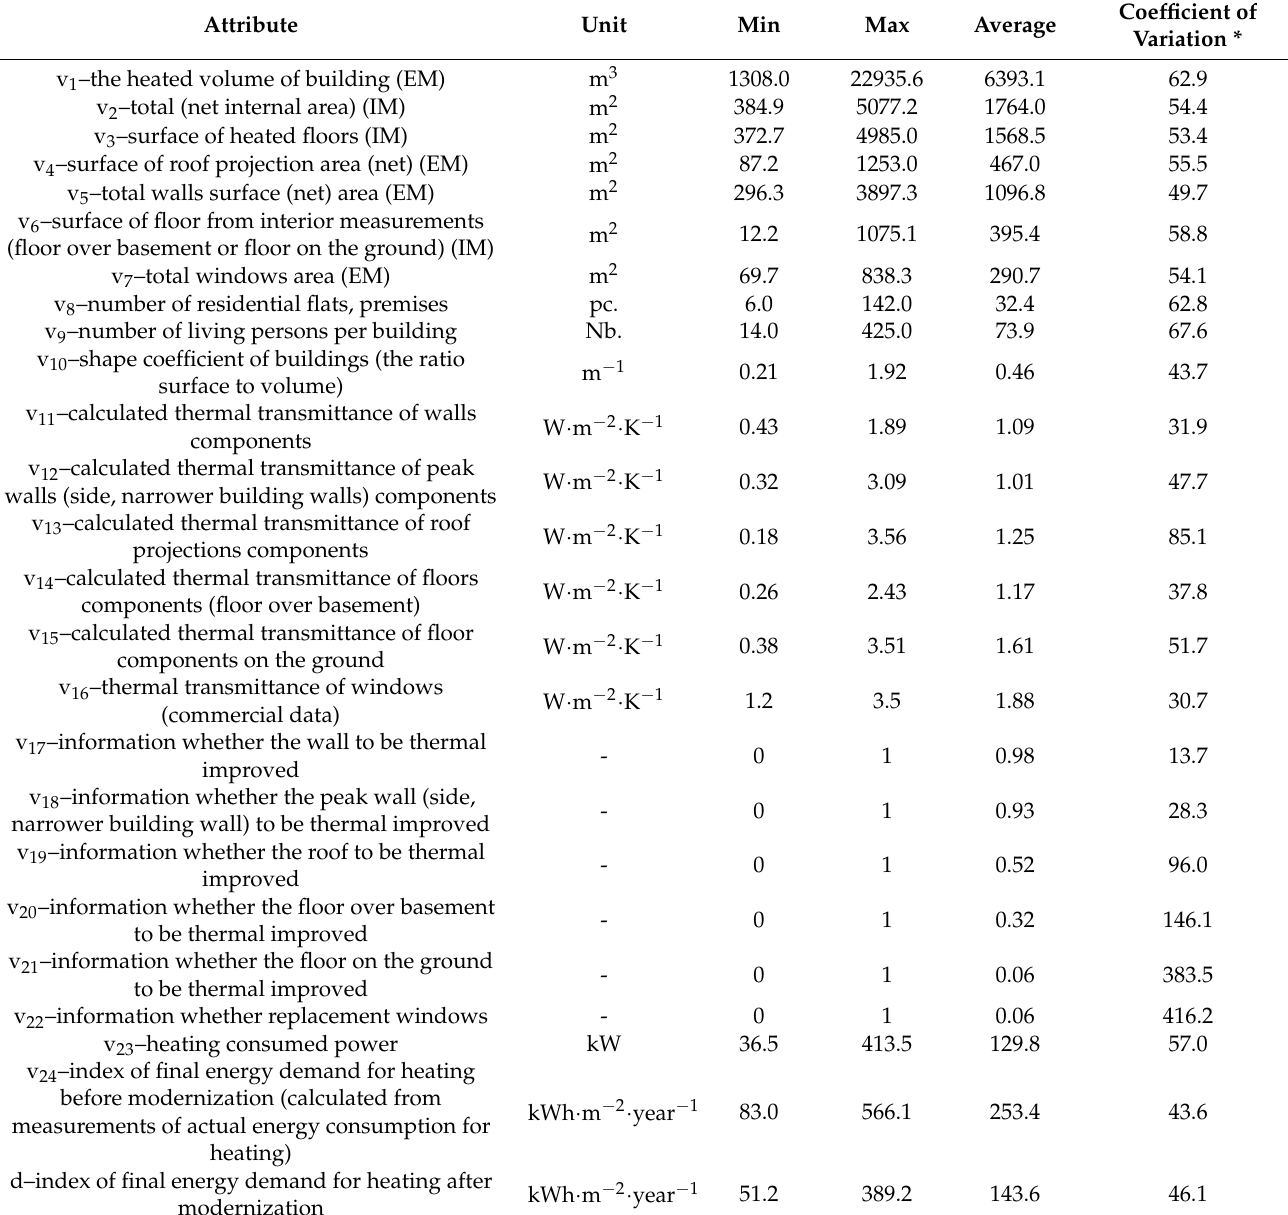
Table 1. Characteristics of features affecting the reduction of annual energy demand for heating in multifamily residential